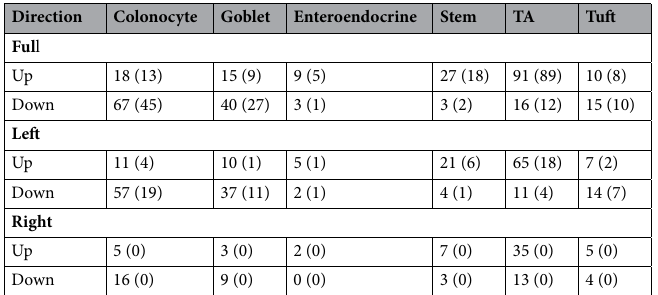
Table 1. Differentially expressed genes in ethanol treated organoids overlap markers of colon cell types. Number of genes surviving FDR are shown in brackets.